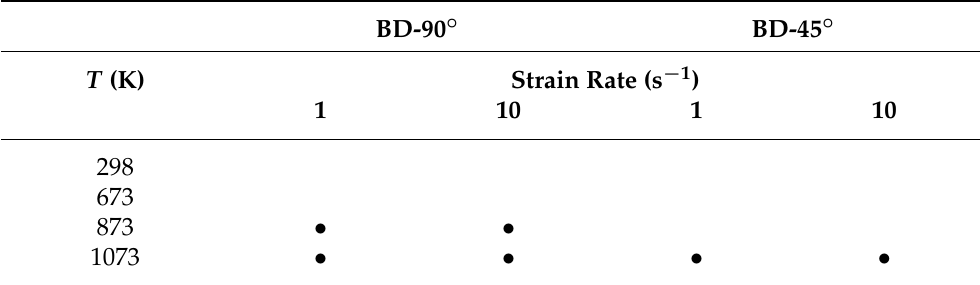
Figure 15. EBSD map performed in the center of Ti42Nb specimen (Figure 13 right) produced with a building direction of 90 ◦ and deformed at a temperature of 1073 K and a strain rate of 10 s − 1 . The compression direction is parallel to the Z-axes. ( a ) Inverse pole figures (IPF(Z)), ( b ) IPF coloring legend, ( c ) pole figures (PF). Table 3. Summary of the occurrence of dynamic recrystallization during uniaxial compression of the Ti42Nb alloy produced at BD-0 ◦ and BD-45 ◦